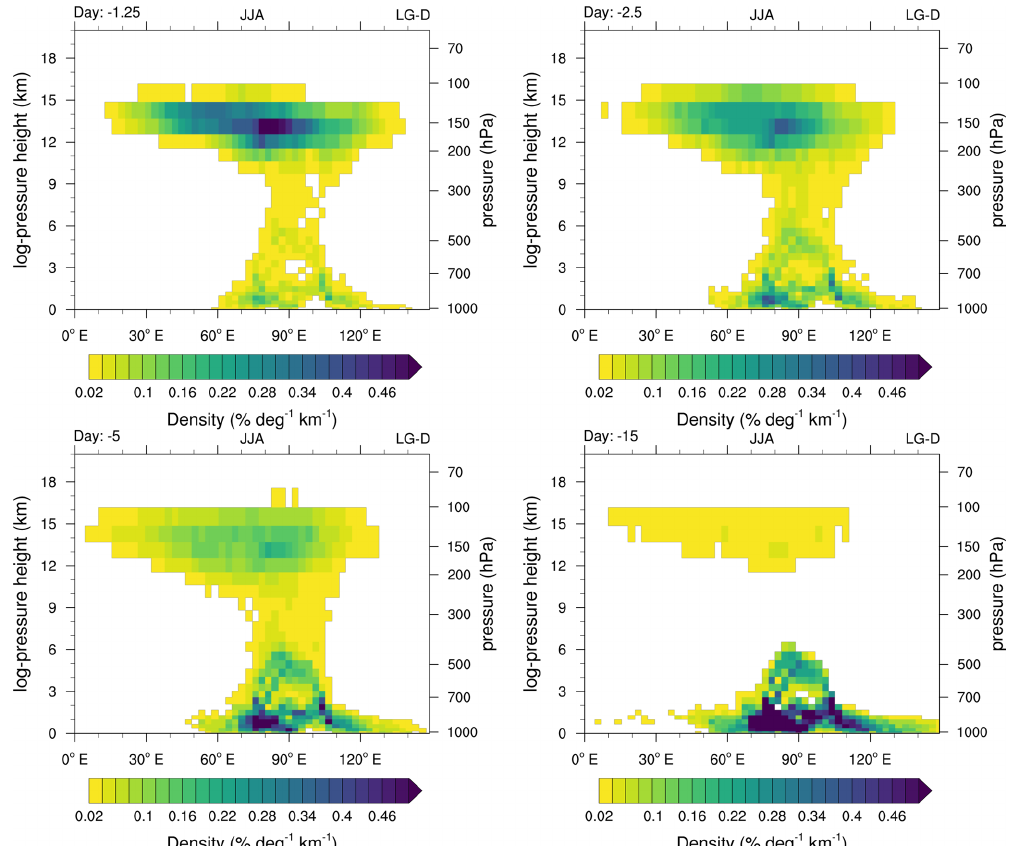
Figure B2. Density of trajectory distributions integrated over 0–50 ◦ N as in Fig. 5 but for the LG-D data from 1981–2010 for 1.25, 2.5, 5 and 15d prior to the arrival of the trajectories in the AMA at approximately